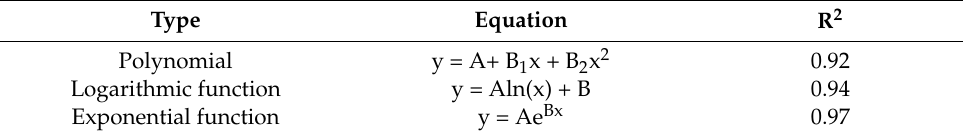
Table 4. Regression analysis of the relationship between compressive strength and porosity. Type Equation R 2 Polynomial